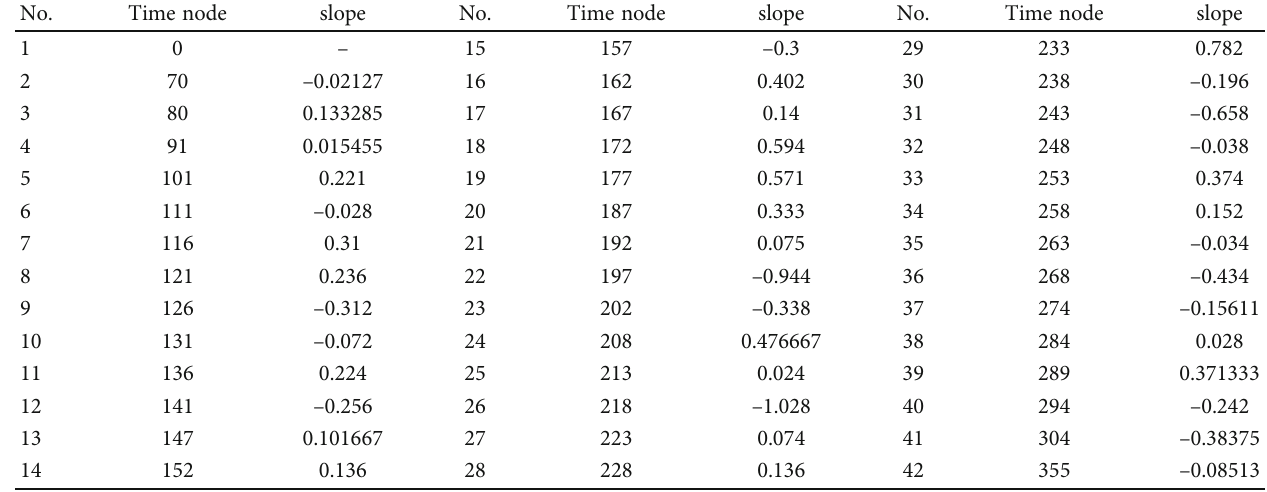
Table 1: Linear piecewise time node and curve slope.